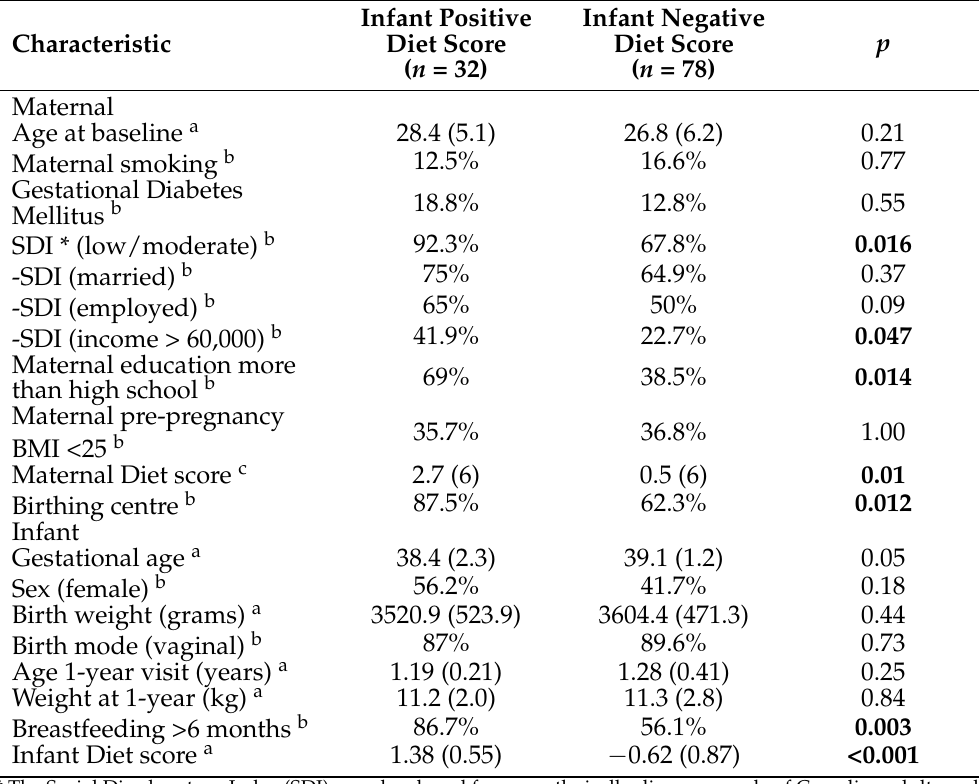
Table 2. Maternal and infant characteristics at age 1-year in positive and negative diet